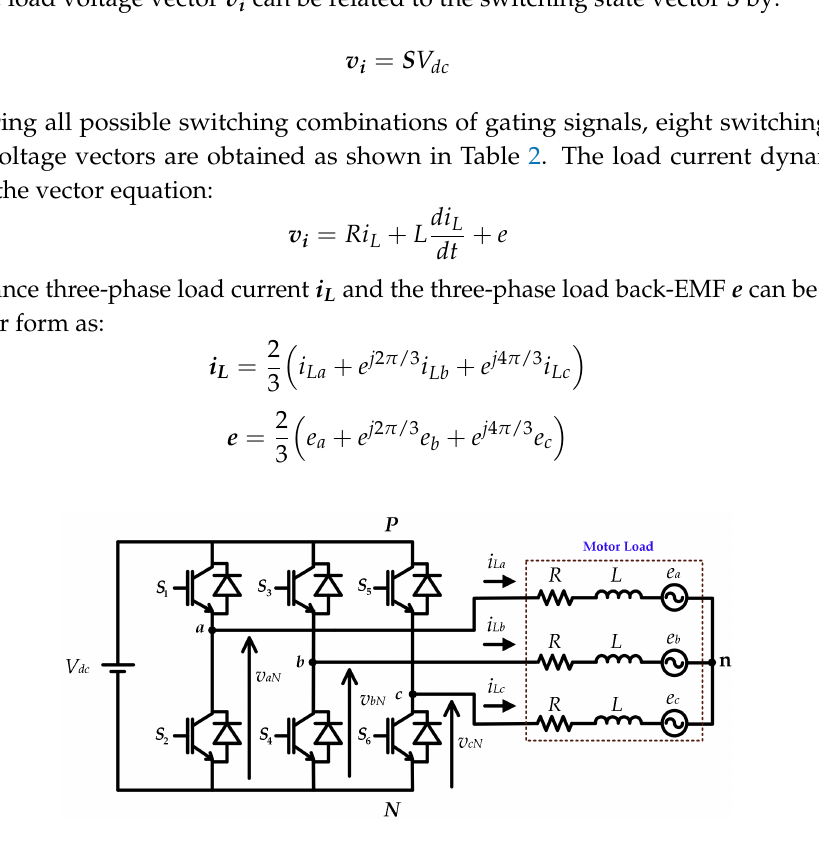
Figure 2. Power circuit of a three-phase voltage source inverter (VSI). Table 1. Gating signals of inverter power switches.